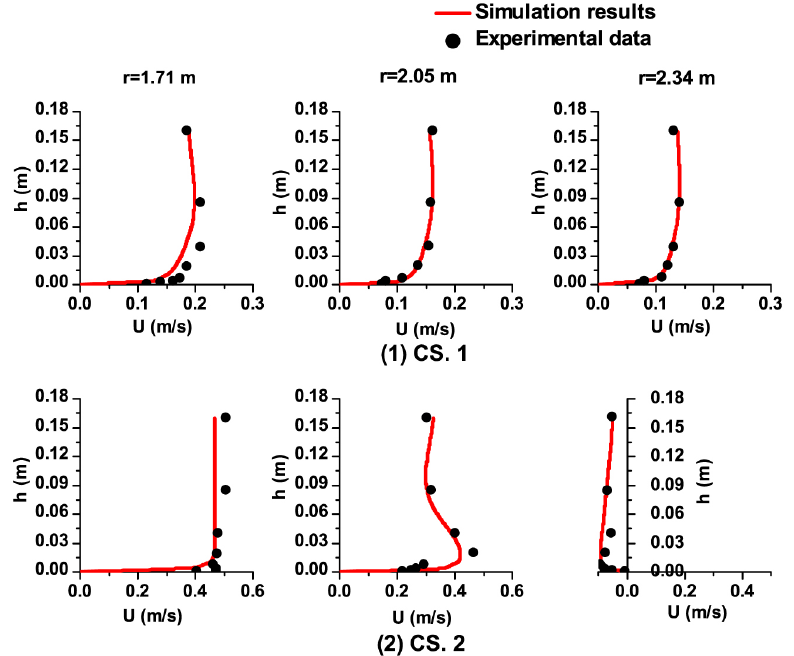
Figure 6. Comparisons of the mean streamwise velocity profiles of the test lines between the simulation results and experimental data.